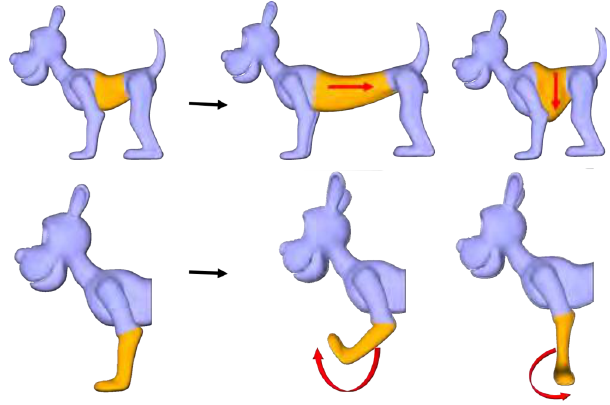
Fig. 7 Anisotropic deformation is performed by selecting vertices (orange) and applying different classes of deformations. Top: a stretch transformation performs anisotropic scaling along the desired direction. Bottom: a local rotation of the surface elements is performed for two different rotation axes. The blue regions remain unaffected and, therefore, act as deformation